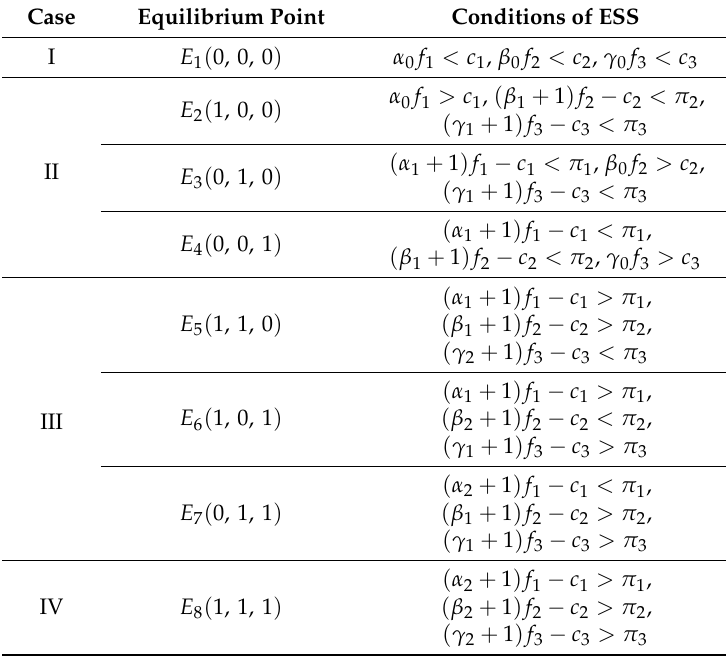
Table 3. The conditions of ESS for all groups adopting pure